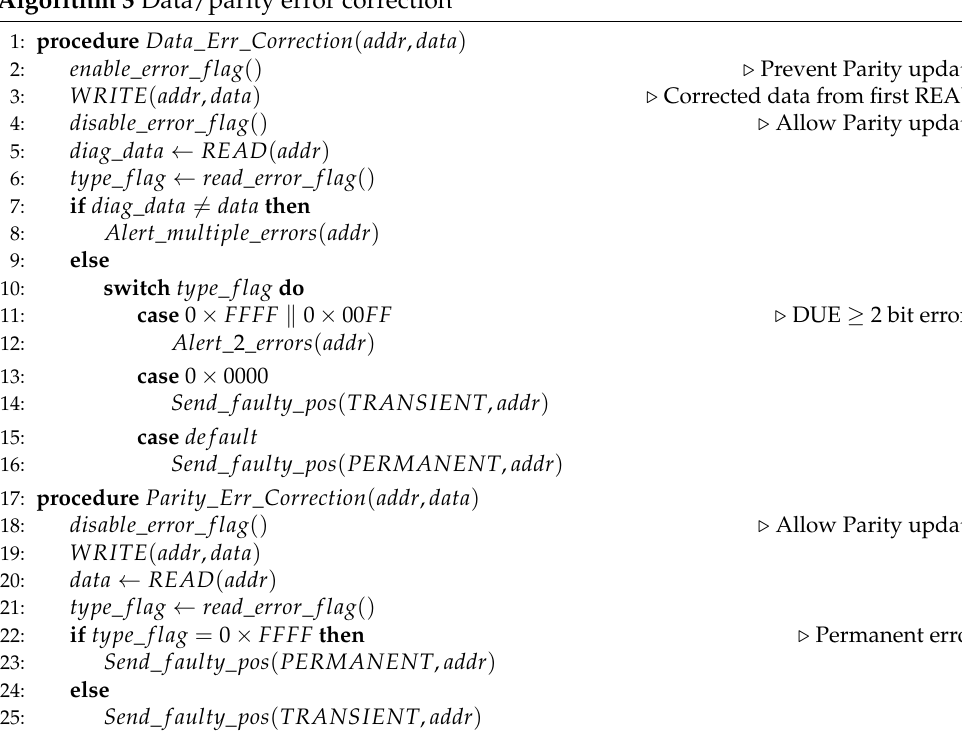
Algorithm 3 Data/parity error